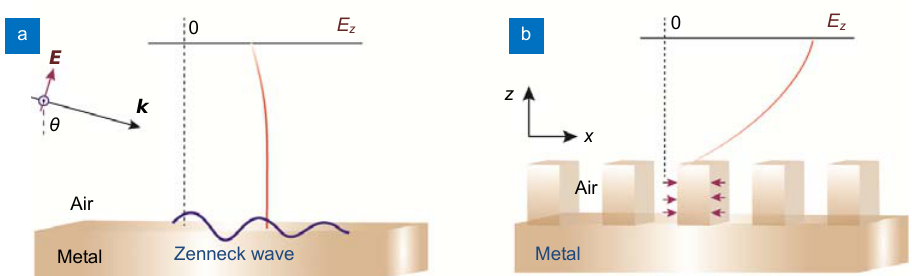
Fig. 1 | ( a ) Electromagnetic reflection on a flat surface at the pseudo-Brewster angle. Note that the reflection minimum is related to the Zenneck surface wave that propagates along the interface between air and a lossy smooth metal. ( b ) Electric field distribution at the pseudo-Brewster an- gle for a posts